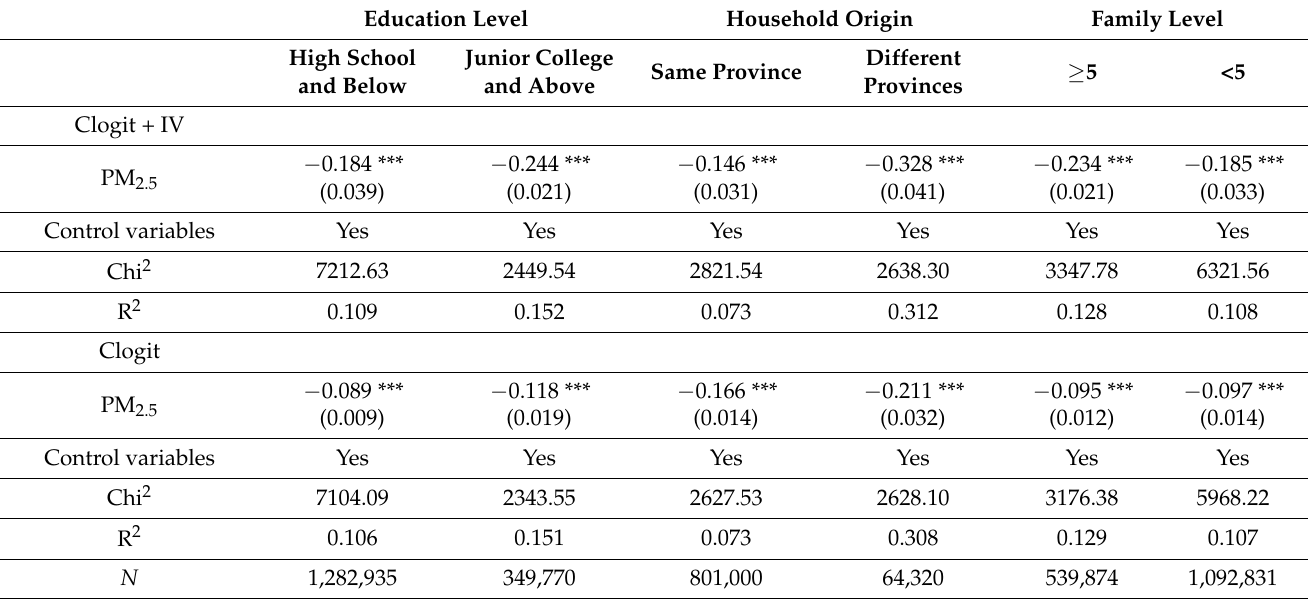
Table 7. Individual heterogeneity: education level, household origin, and family level. Education Level Household Origin Family